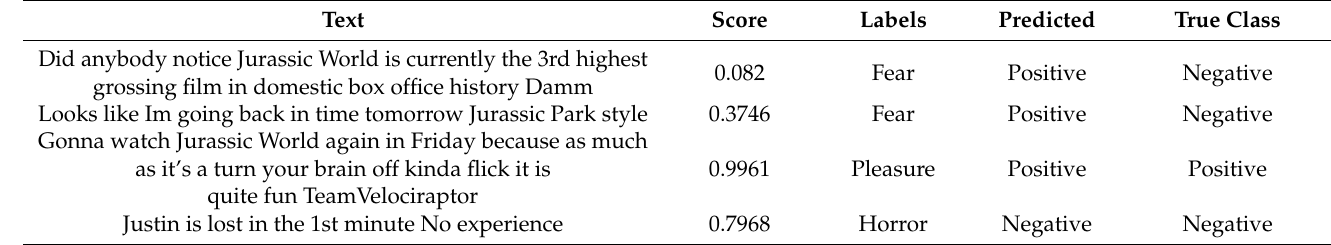
Table 9. Misclassified instances and their probability score for the binary classification of the SemEval-2017 dataset and ensemble learning method.